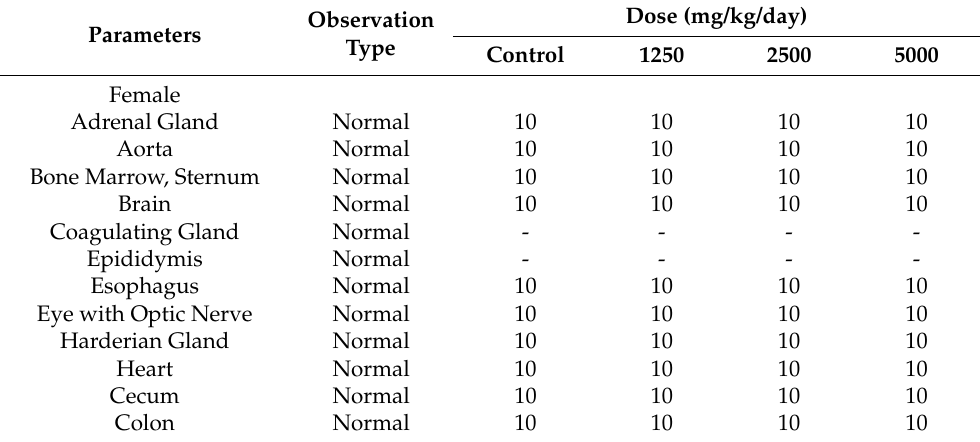
Table 14. Necropsy findings in 13 weeks repeated oral dose toxicity of WG extract in female